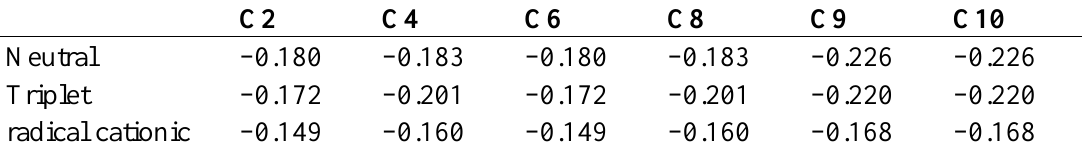
Table 2. Charge distribution on the carbon atoms for 4 compound.